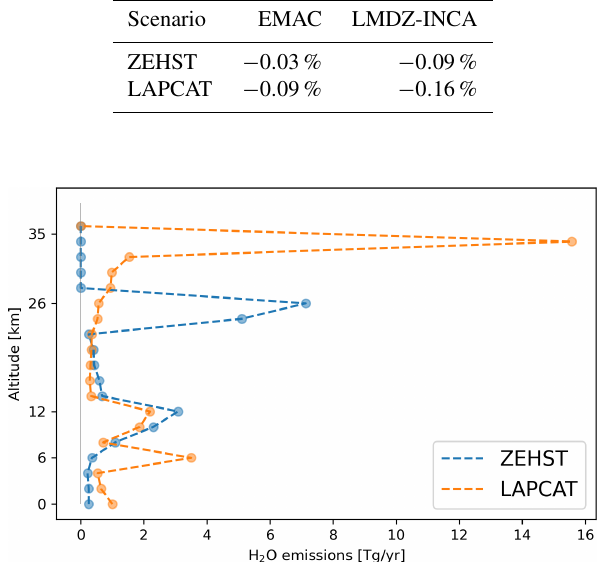
Figure A1. Vertical distribution of annual H 2 O emission for ZEHST and LAPCAT. The peak at 6km altitude comes from the hypersonic boost of the LAPCAT aircraft. The vertical distribution was aggregated for a better comparability (with a 2km bin size). For the total amount of emissions, see Table 2.